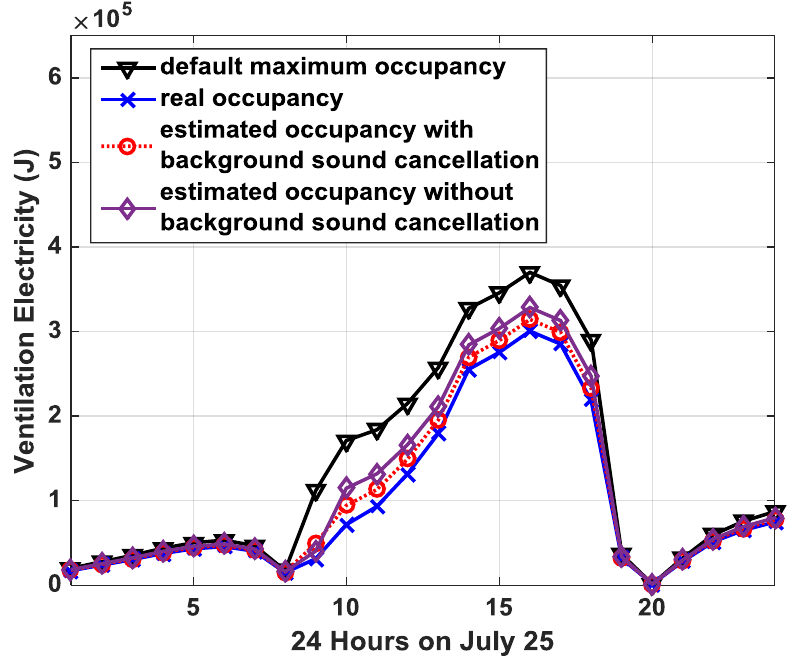
Figure 11. Simulation results of hourly ventilation electricity for 25 July.